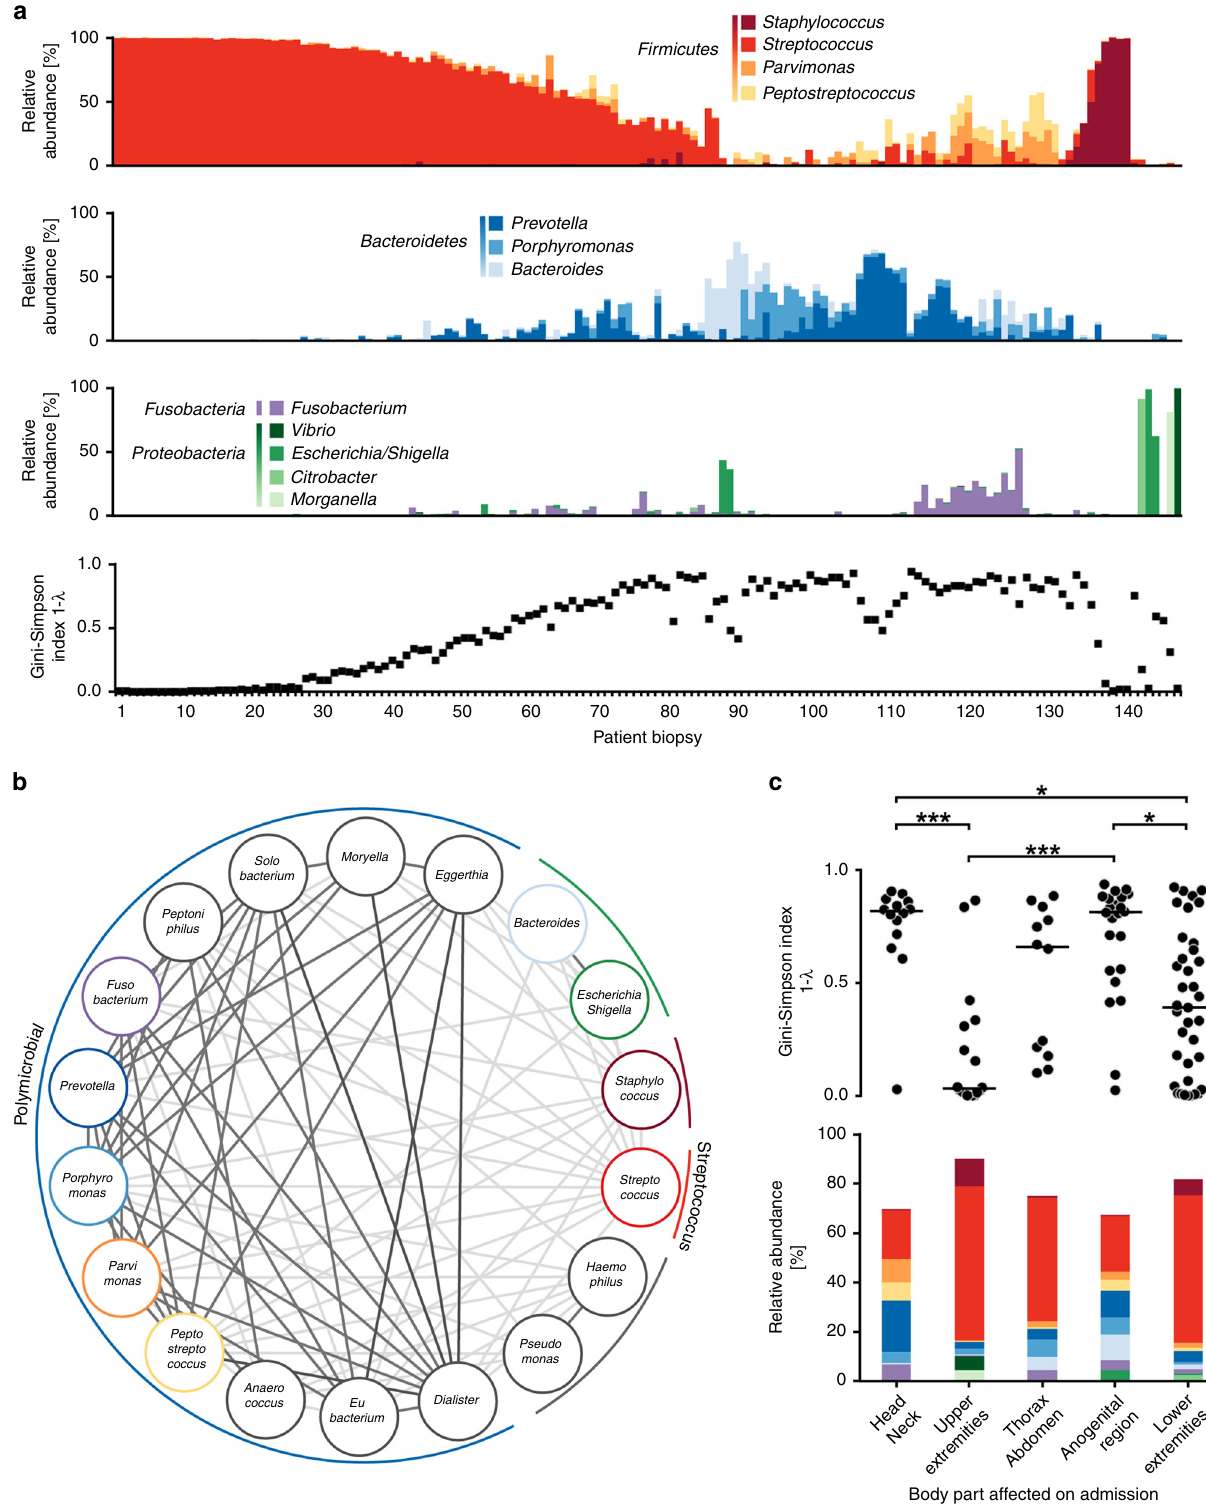
(GO:0016485) predominated in the transcriptional pro fi le of the bacteria associated with polymicrobial NSTIs (Fig. 3, Supple- mentary Data 5). Furthermore, lipopolysaccharide core region biosynthesis (GO:0009244), lipid A biosynthesis (GO:0009245), and polysaccharide transport (GO:0015774), all of which are involved in the synthesis and transport of lipopolysaccharide